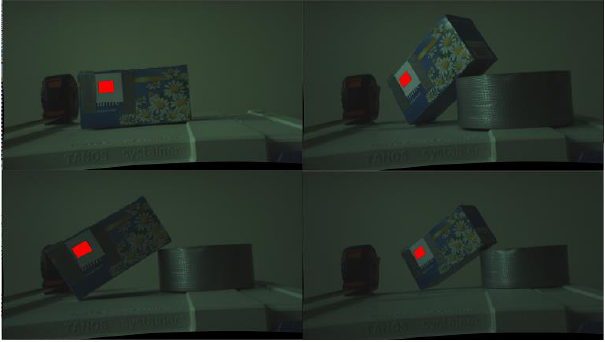
Fig. 5. Object recognition with a mark of colored image from different position and orientation in a dark condition.